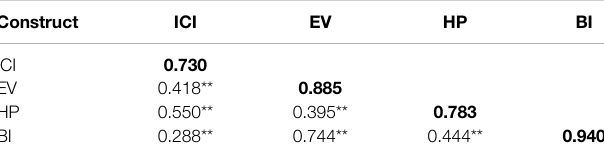
TABLE 5 | Fit indices of the structural model.